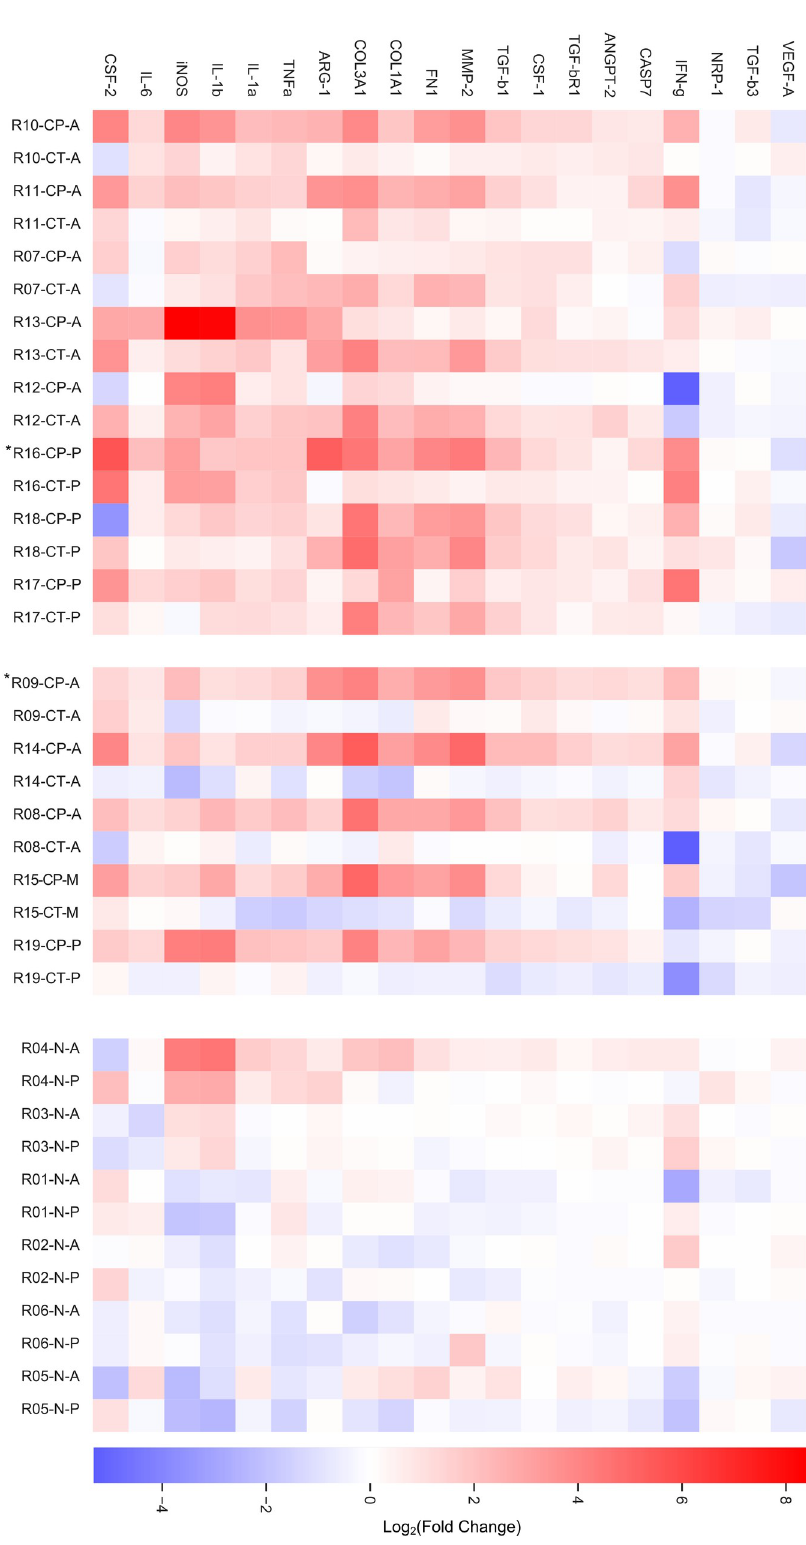
Fig 4. NCC rat model shows a predominance of pro-inflammatory and fibrosis-related response with changes in gene expression tissue distant to the parasite. Genes with significant changes in gene expression compared to